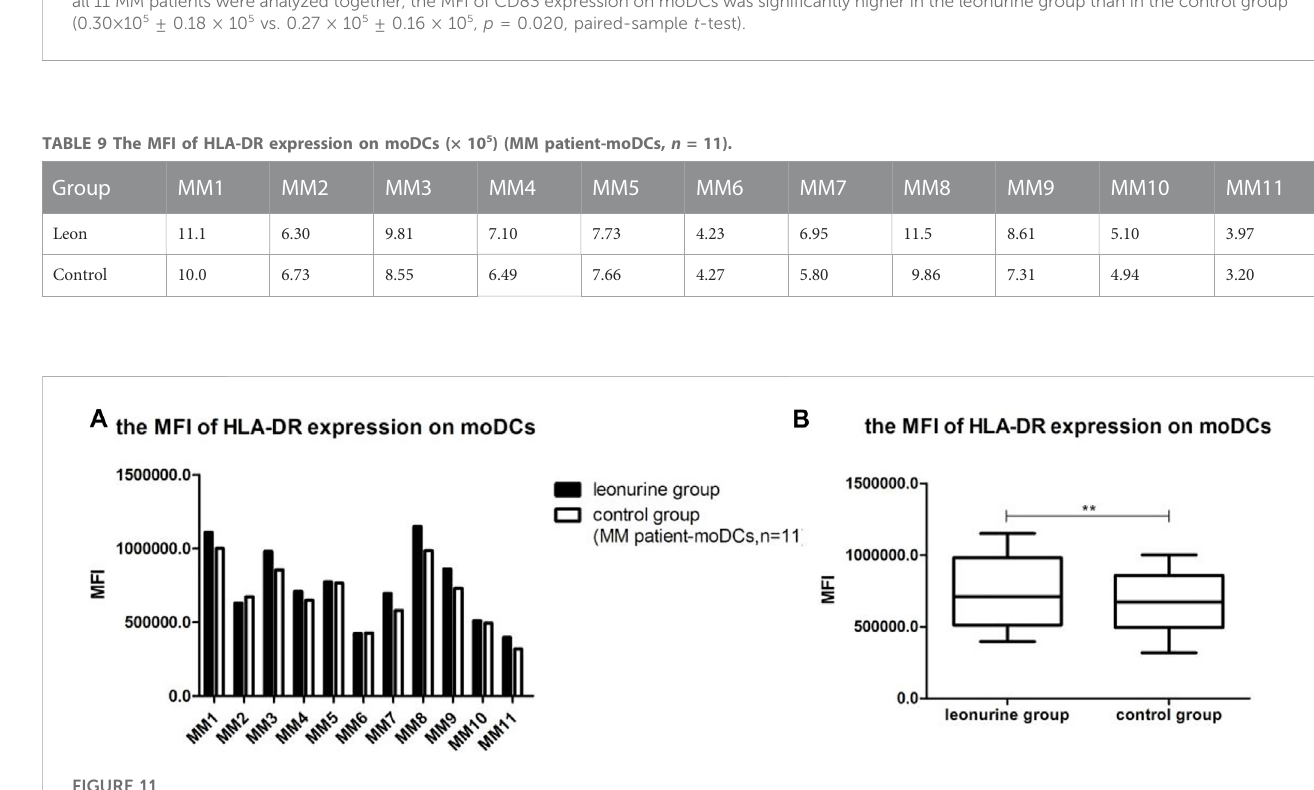
FIGURE 11 TheMFIofHLA-DRexpressiononmoDCsbetweentheleonurinegroupandthecontrolgroup(MMpatient-moDCs, n =11). (A) ThegraphshowstheMFI of HLA-DR expression on moDCs between theleonurine group and the control group for each MM patient. (B) The boxplot shows that when moDCs derived from all 11 MM patients were analyzed together, the MFI of HLA-DR expression on moDCs was signi fi cantly higher in the leonurine group than in the control group (7.49 × 10 5 ± 2.58 × 10 5 vs. 6.80 × 10 5 ± 2.18 × 10 5 , p = 0.006, paired-sample t